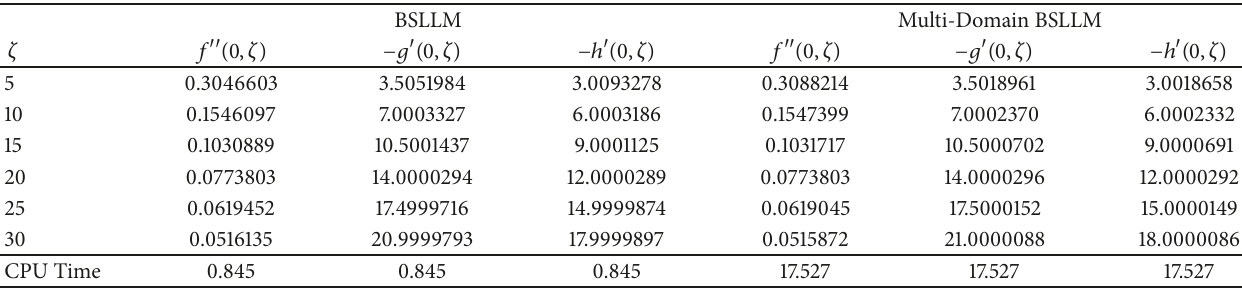
Table 3: Comparison of the MD-BSLLM and the BSLLM solution for 𝑓 󸀠󸀠 (0,𝜁) , −𝑔 󸀠 (0,𝜁) , and −ℎ 󸀠 (0, 𝜁) : 𝑁 𝜂 = 60 , 𝑁 𝜁 = 5 , 𝑛 = 𝑤 = 1/2 , 𝑃𝑟 = 0.7 , 𝑆𝑐 = 0.6 , and 𝑧 = 40 . BSLLM